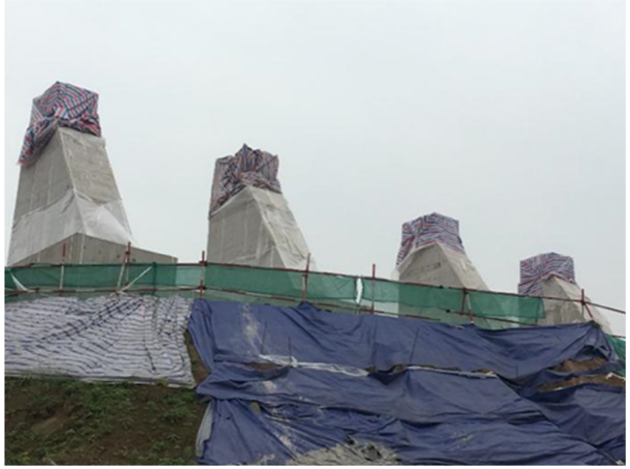
Figure 6. Conservation film curing